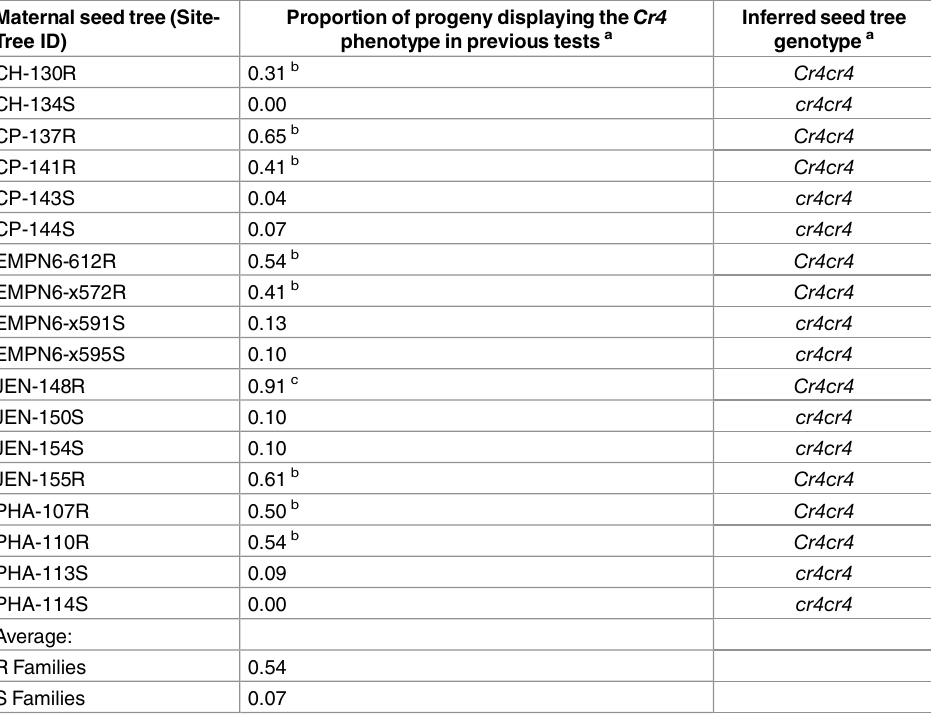
Table 1. The inferredgenotypes of limberpine seed trees and the diseaseresistant phenotypes of theirrespectiveseedlingfamiliesused in thisstudy for the testof constitutivecostsof complete resistance. Maternal seed tree (Site- Proportion of progeny displaying the Cr4 Tree ID) phenotype in previous tests